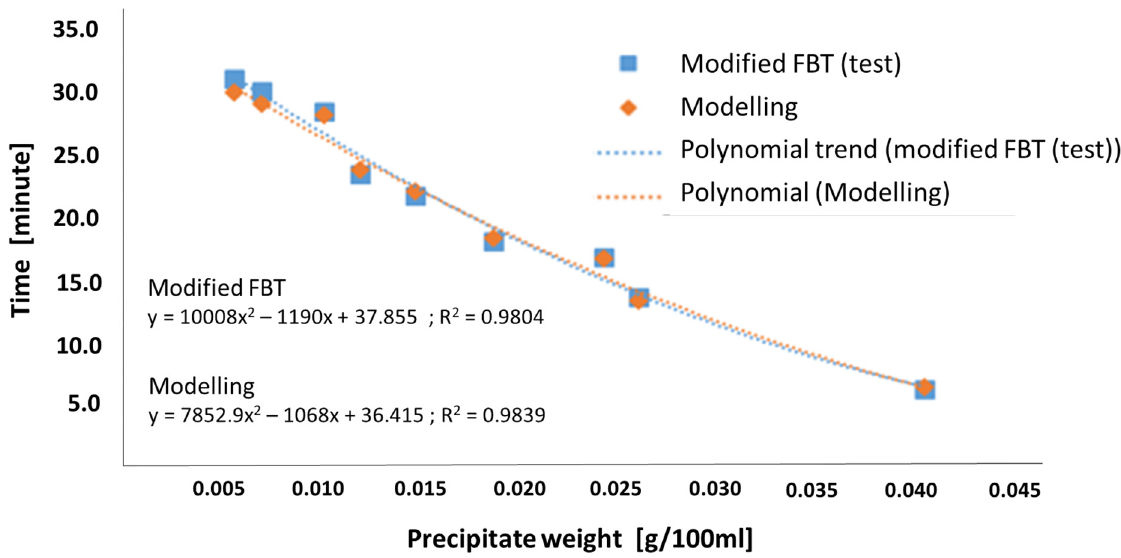
Figure 6. The time to reach pressure drop of 30 kPa vs. precipitate weight from modified FBT test and modelling.